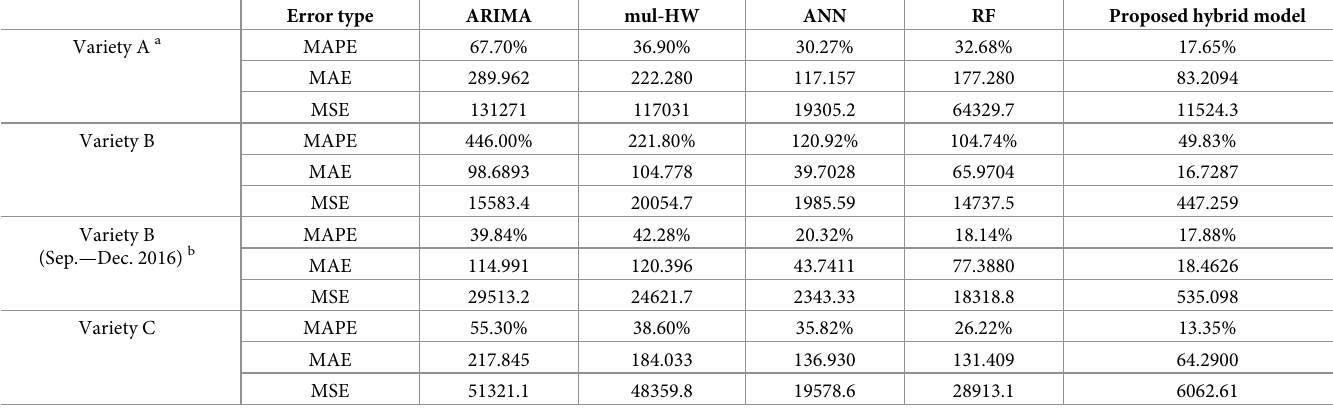
Table 2. The comparison of demand forecasting performance on the testing set among different